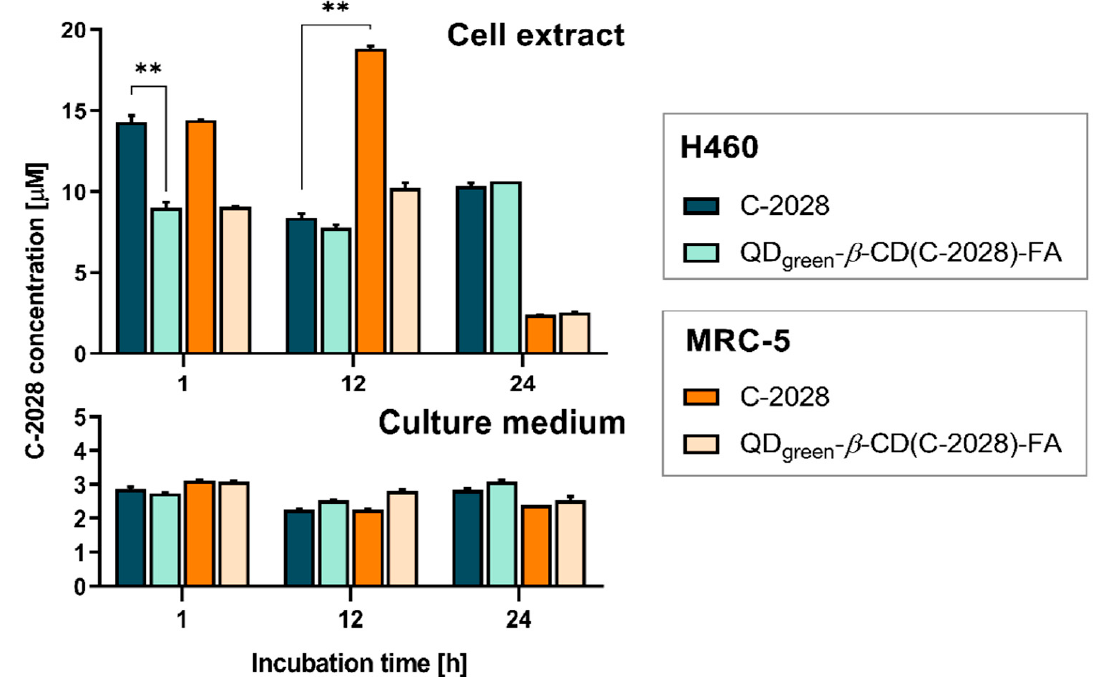
Figure 7. The concentration profiles of C-2028 in H460 (cancer) and MRC-5 (normal) lung cells treated with 35 µ M unbound C-2028 and QD green - β -CD(C-2028)-FA nanoconjugate for 1, 12, and 24 h obtained by reversed-phase HPLC analysis of cell extract ( top ) and culture medium ( bottom ). Data are expressed as the mean ± standard deviation of two independent experiments. The results were analyzed by one-way ANOVA with Dunnett’s multiple comparisons vs. unbound C-2028 (in H460 cells), ** p < 0.01.